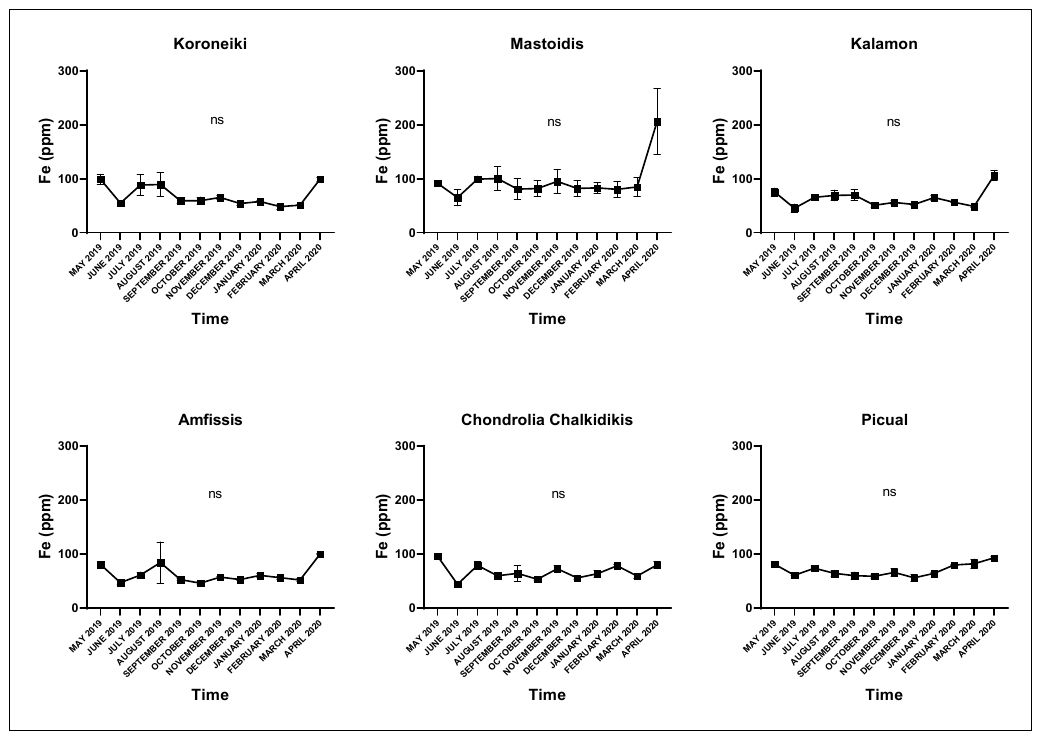
Figure 4. Seasonal trends of iron concentration in olive leaves that developed during annual growth. Error bars represent the standard error of the mean of three replicates. Means were compared at p < 0.05 (LSD test).